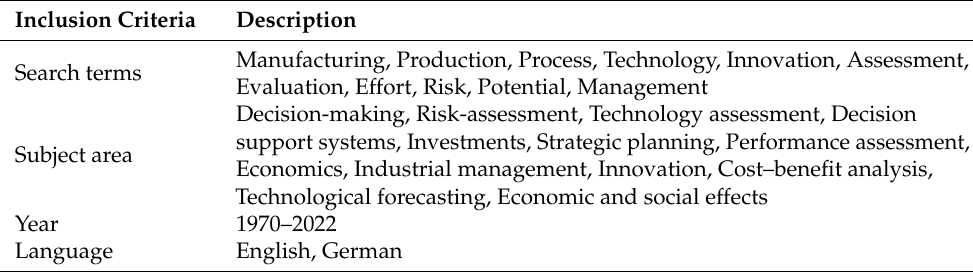
Table 1. Inclusion criteria for the systematic literature review.